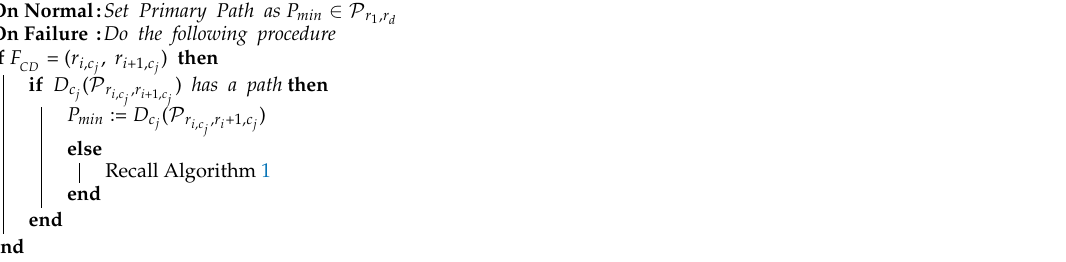
Algorithm 2 Find the shortest path with Dijkstra on the basis of either G or the affected community ( c j